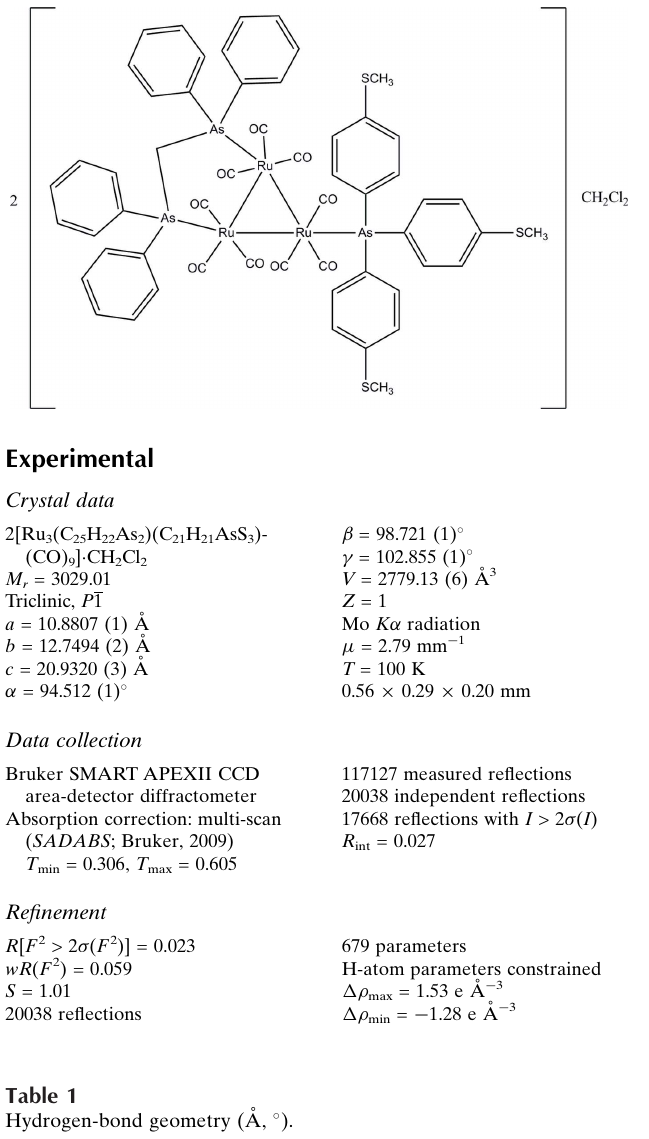
Hydrogen-bond geometry (A˚ , (cid:3)